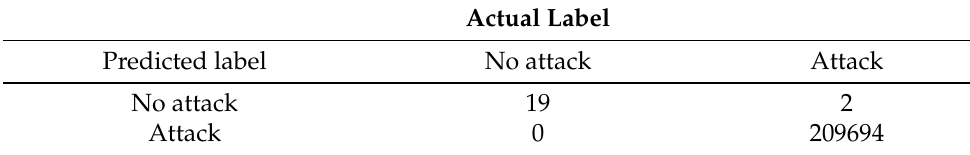
Table 35. DoS TCP DT confusion matrix.